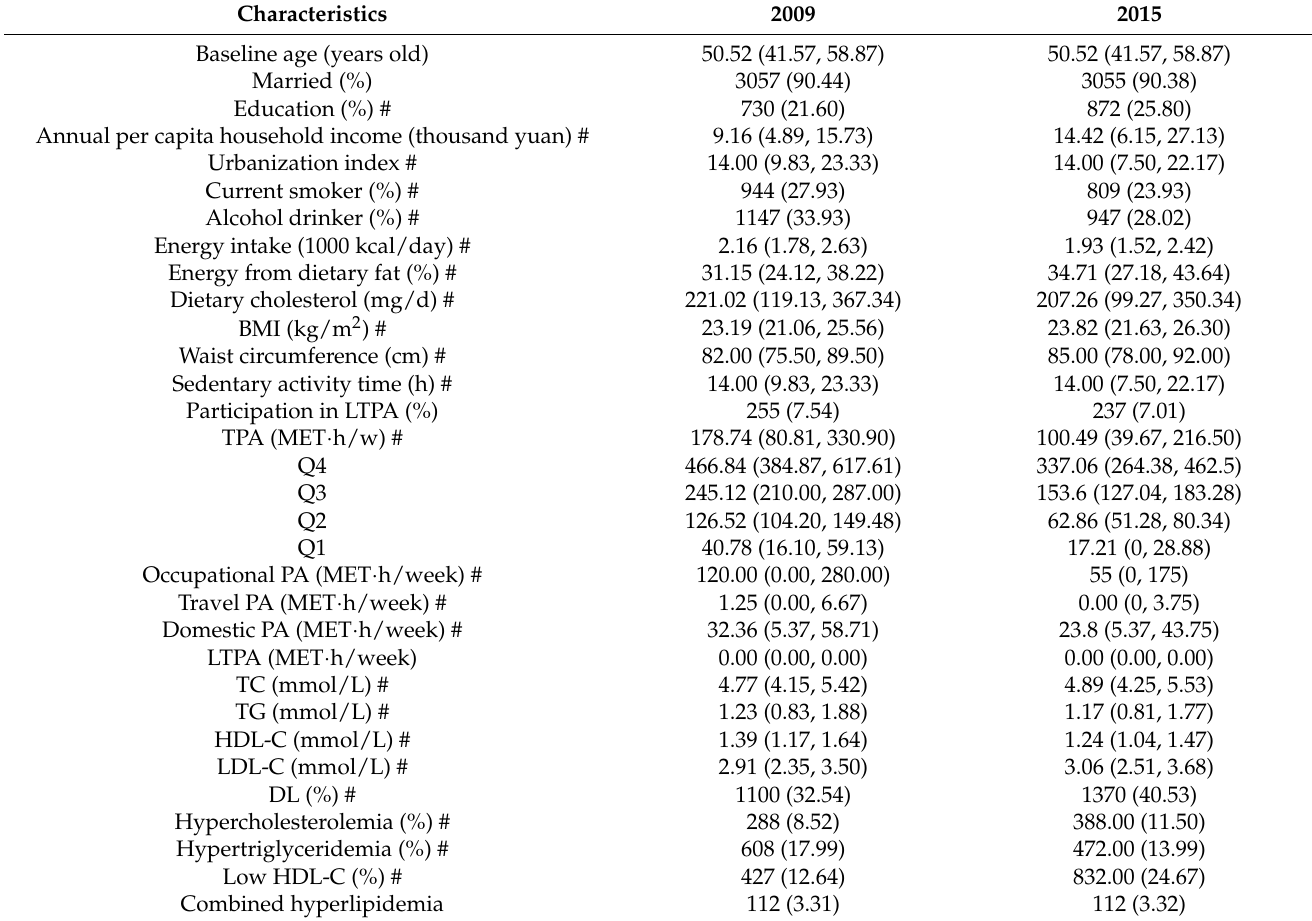
Table A1. Demographic characteristics of samples from nine provinces of China in 2009 and